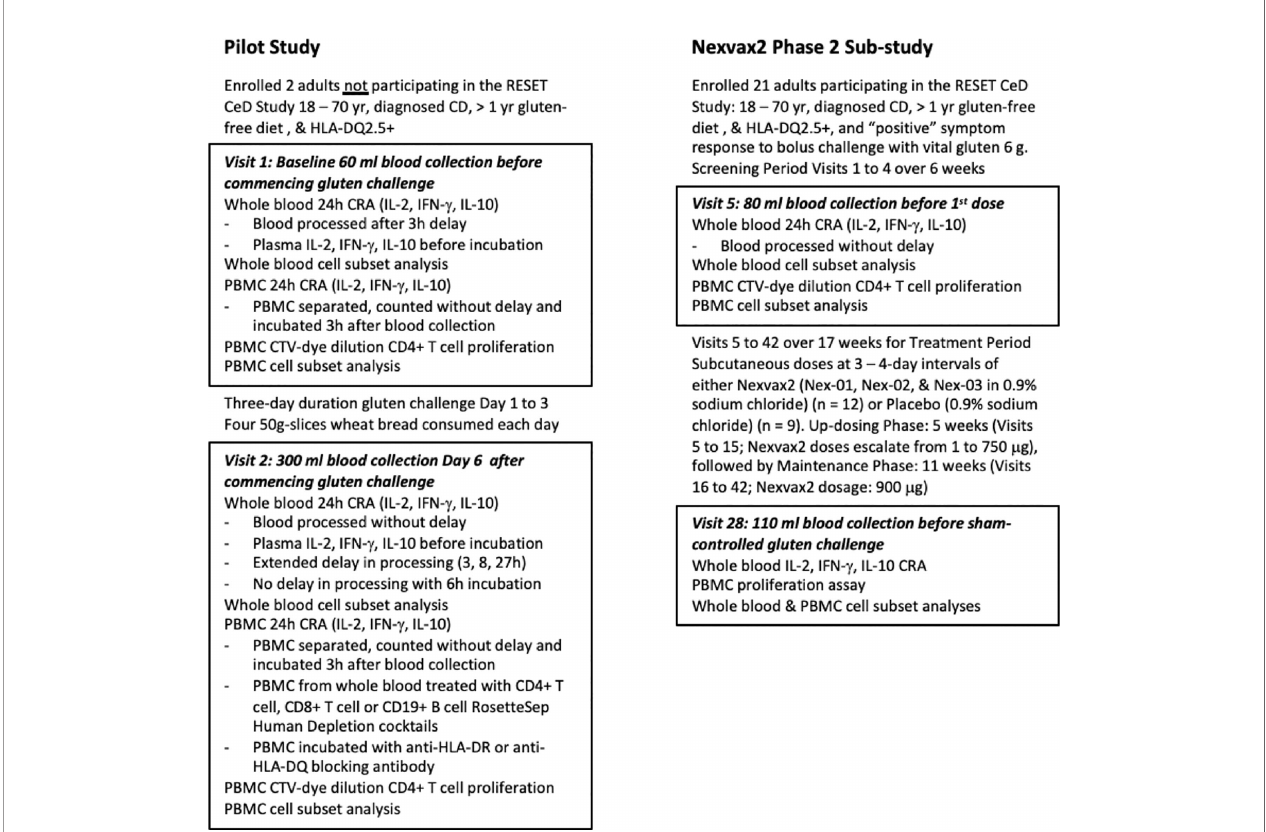
FIGURE 1 | Study overview. The pilot study included two participants prior to commencement of the Nexvax2 Phase 2